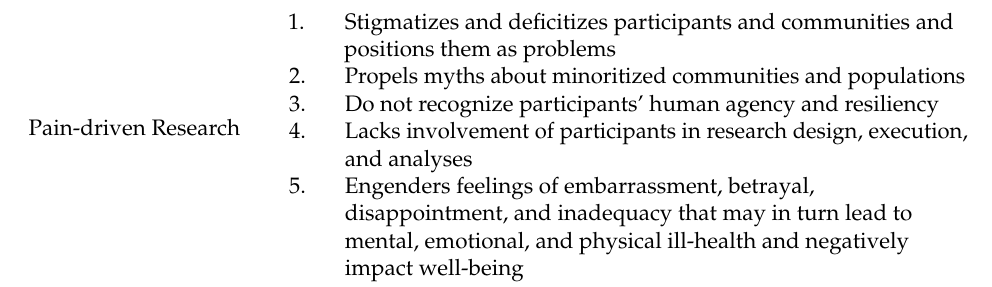
Table 1. Damage and Deficit- Centered Qualitative Research.